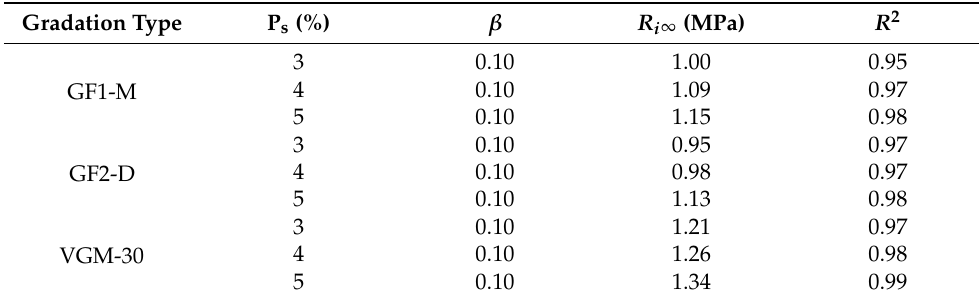
Table 8. Splitting strength growth equation parameters.